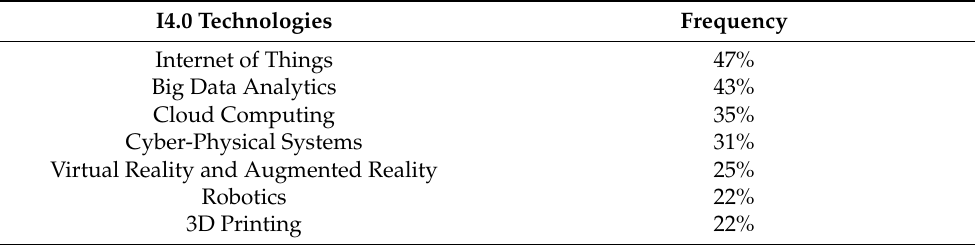
Table 4. Most relevant I4.0